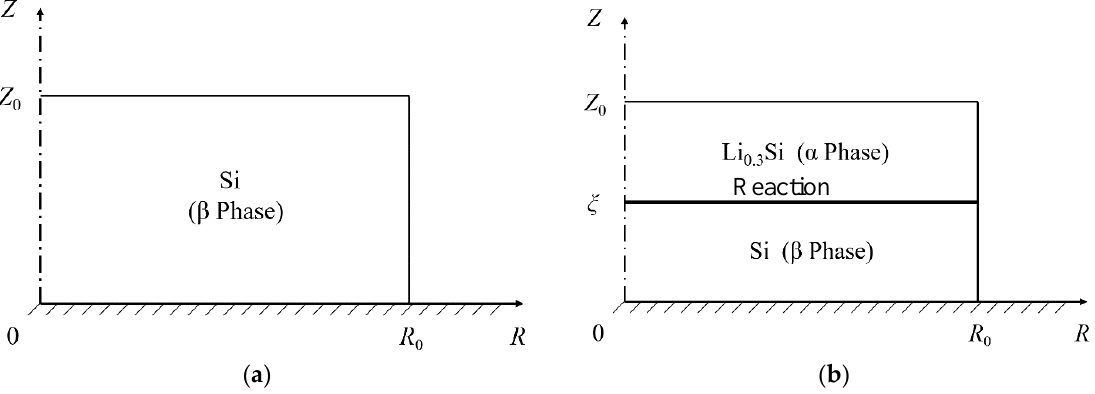
Figure 4. Schematic of Li diffusion in an a-Si thin film electrode at ( a ) stage 0, and ( b ) stage I with the formation of Li-poor phase Li 0.3 Si ( α phase) and a phase boundary (reaction front), ξ . In a cylindrical coordinate ( R , Θ , Z ), lithium diffuses into the thin film from the surface of Z = Z 0 and the thin film is fixed on the substrate at Z = 0. The pristine un-lithiated silicon is denoted as β phase.